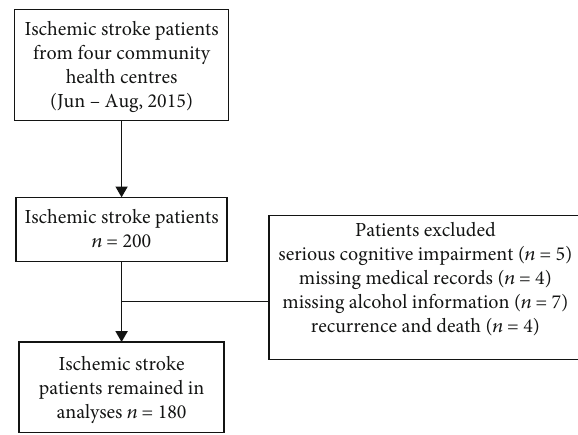
Figure 1: Flowchart of the participant selection process.